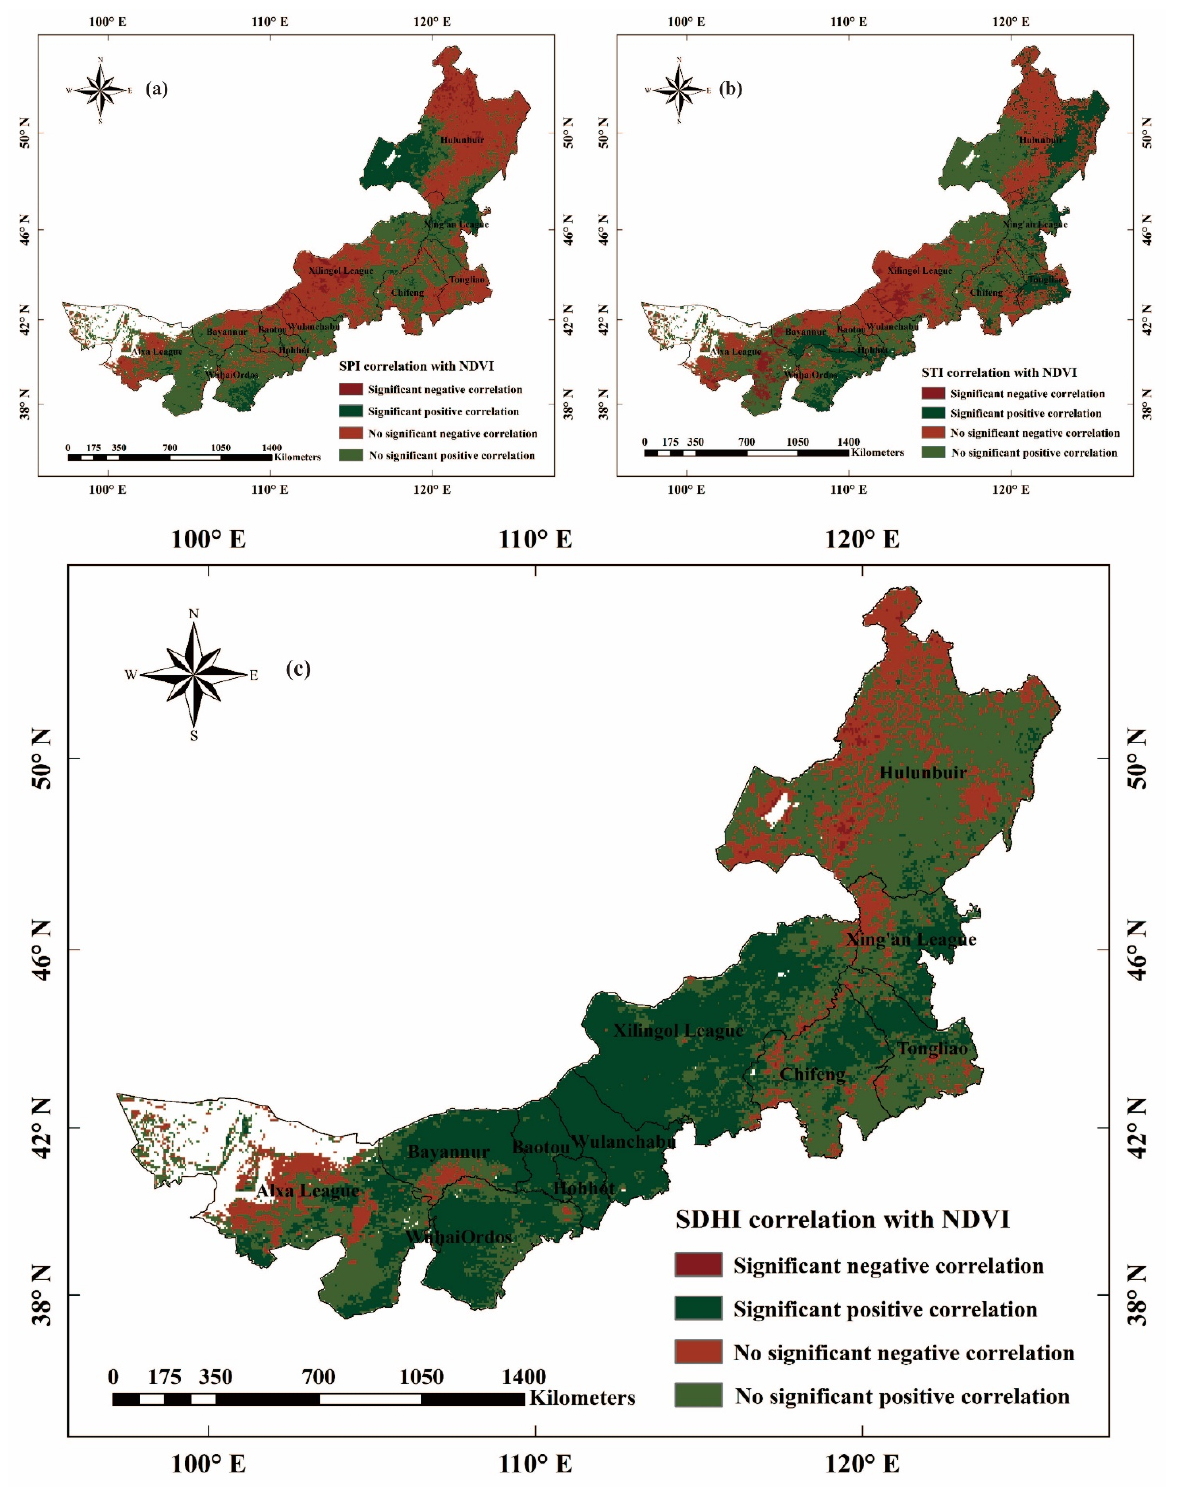
Figure 9 . Spatial distribution of partial correlations between SPI, STI, SDHI, and NDVI in Inner Mongolia from 1982 to 2020. ( a ) SPI correlation with NDVI, ( b ) STI correlation with NDVI, ( c ) SDHI correlation with NDVI.